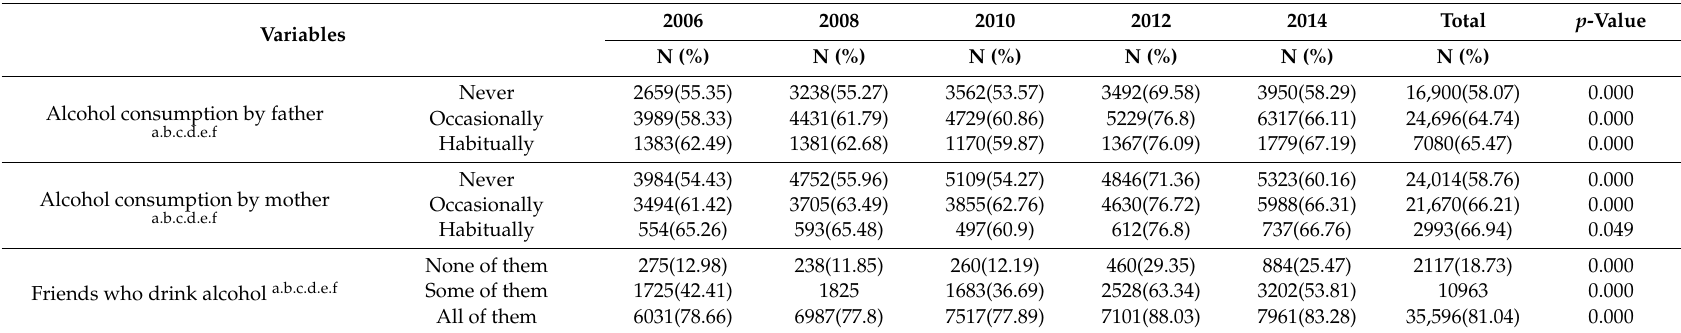
Table 3. Prevalence of alcohol consumption among Spanish female adolescents aged 14 to 18 years, according to variables related to the influence of the environment and use of licit and illicit drugs. ESTUDES surveys